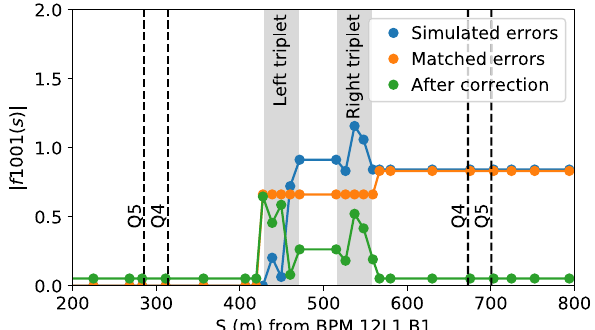
FIG. 3. Example of a simulation of HL-LHC with roll errors in the triplet and Q4-5 quadrupoles. The effect of these errors in the j f j is shown in blue. The suggested effective correction is 1001 shown in orange, but it should be noted that the matching routine matches the real and imaginary parts of the f 1001 resonance driving term. The effect of the correction is shown in green. FIG. 4. Simulation of the evolution of the β (cid:1) error from K- modulation with the design β (cid:1) . The effect of a tune uncertainty of 2 . 5 × 10 − 5 is shown in the blue line. The orange line (partially covered by the green line) also considers the modulating quadru- pole fringe fields. In the green and red lines a 10 − 3 relative uncertainty in the field of the modulating quadrupole and a 2 mm uncertainty in the longitudinal position of the quadrupole have been respectively